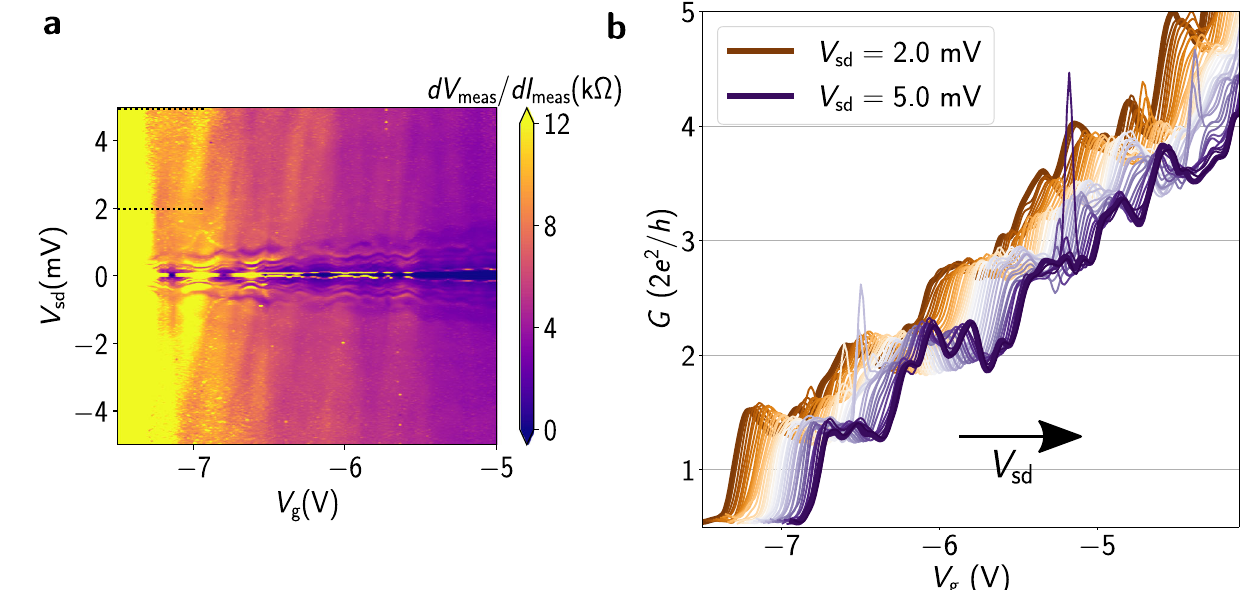
2.0mVand5.0mV(shownbydashedblacklinesin a inincrementsof0.125mV,and are each offset along the V g axis (arrow indicating direction of increasing V sd ) by 3mV for clarity. sd